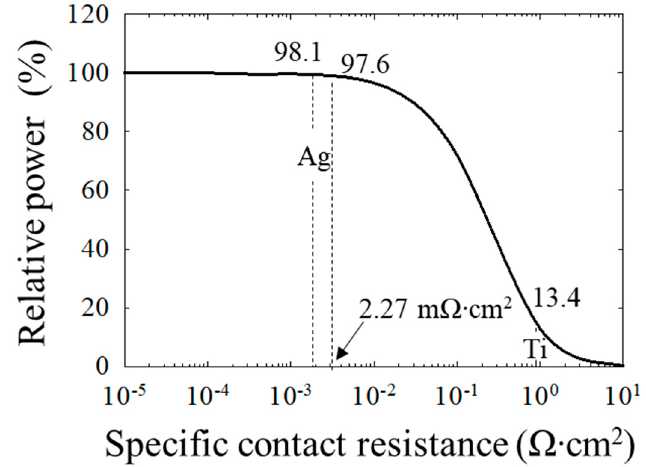
Figure 4. The simulation result of relation between power output and SCR depending on the